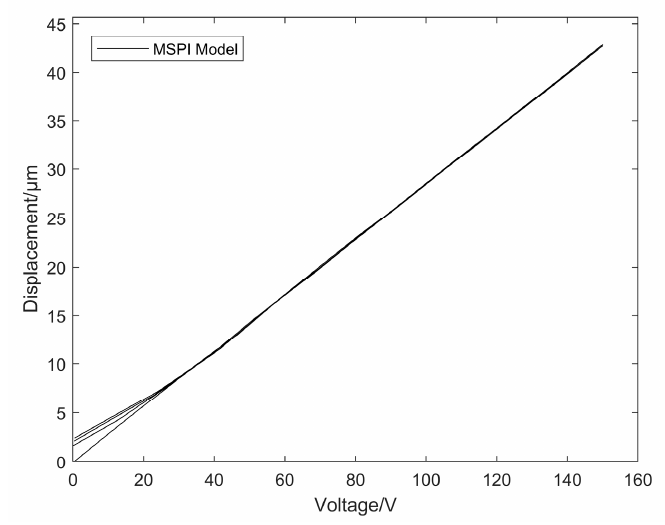
Figure 24. Compensating control effect of MSPI inverse model.